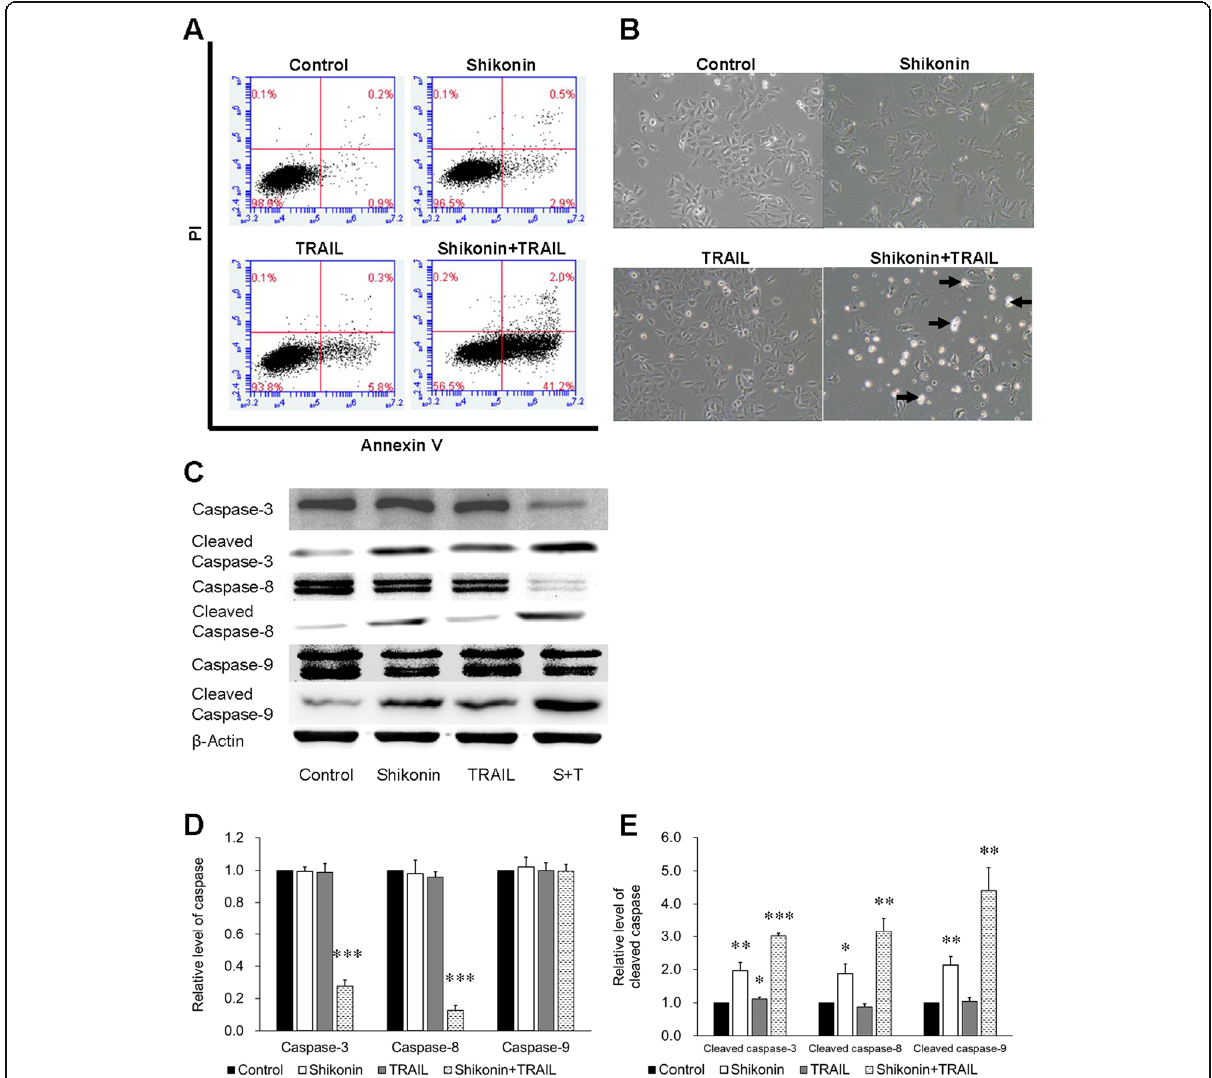
Fig. 2 Synergistic effect of shikonin and TRAIL on apoptosis induction in TRAIL-resistant A549 cells. a A549 cells were pretreated with shikonin (4 μ M) for 12 h and then exposed to TRAIL (50 ng/ml) for another 12 h. Cells were harvested to quantify the induction of apoptosis by annexin V/ PI staining and flow cytometry. The data in each plot indicated the percentage of apoptotic cells. b Cell morphology was analyzed under an inverted microscope (magnification × 100) after cells were treated as described in ( a ). c Whole cell lysates were prepared after cells were treated as described above and were analyzed by Western blotting using antibodies specific to caspase-3, − 8, − 9 and cleaved caspase-3, − 8, − 9. β - Actin was used as the loading control. d-e The data are presented as the means ± SDs of at least three independent experiments, and significant differences between the control group and the other groups in each experiment are shown as* p < 0.05, ** p < 0.01 and *** p < 0.001. S +